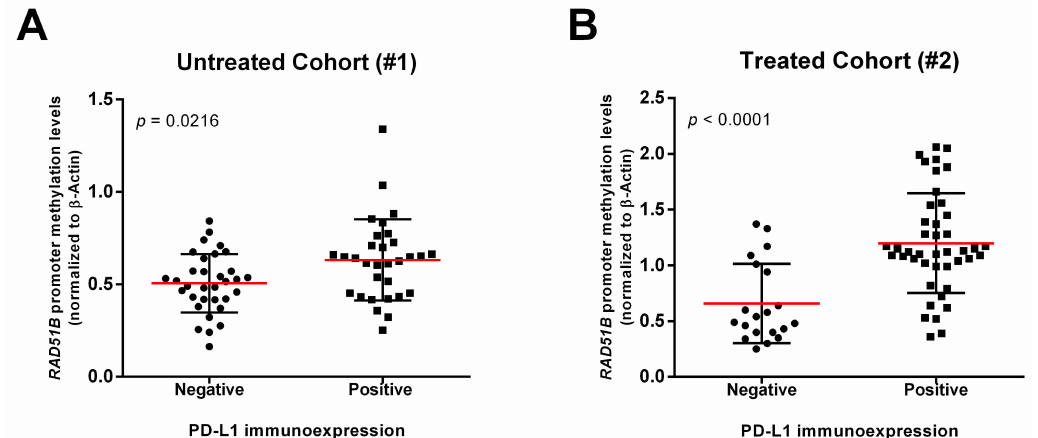
Figure 1. RAD51B promoter methylation levels within PD-L1 negative and PD-L1 positive immunoexpression among NSCLC samples. Scatter plot representing RAD51B promoter methylation levels distribution obtained by qMSP for ( A ) Untreated Cohort (#1) and ( B ) Treated Cohort (#2) patients, according to negative and positive PD-L1 immunoexpression. Mann–Whitney U-test. Red horizontal line represents the median methylation levels.